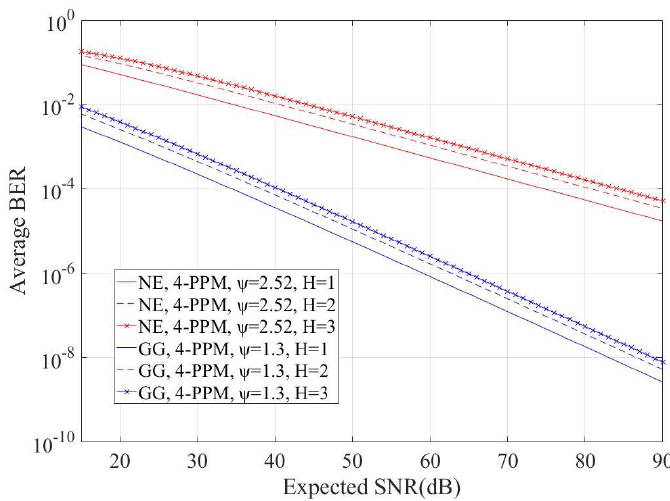
Figure 3. ABER of 4-PPM scheme versus the expected SNR.